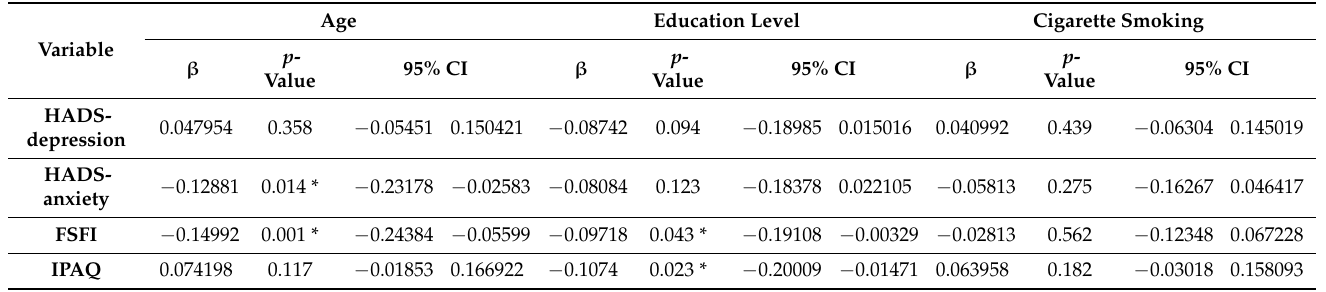
Table 6. Multivariate logistic regression